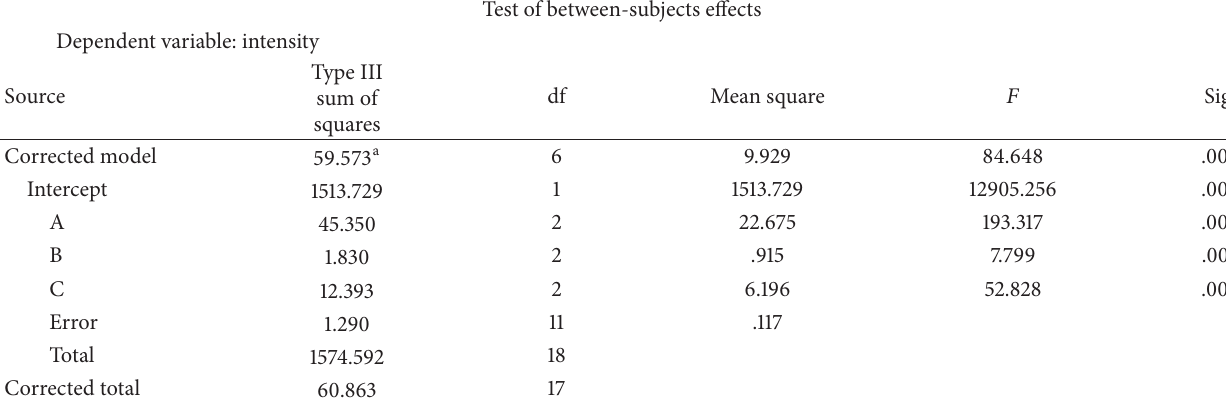
Table 2: Analysis of variance of tensile